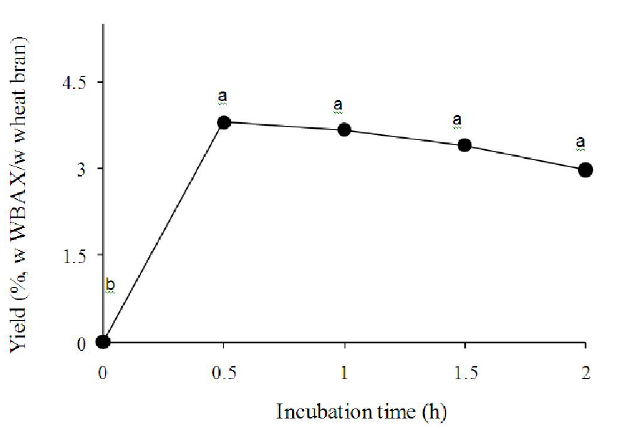
Figure 1. Yields of wheat bran ferulated arabinoxylans (WBAX) extracted under different incubation times in 0.5 M NaOH at 25  С and 100 rpm in darkness. The presented results are averages of three replicates. Mean values with different letters are significantly different ( P < 0.05).